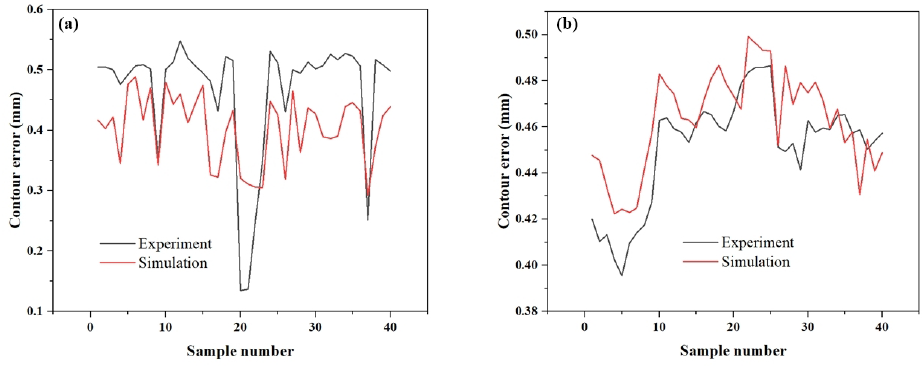
Figure 3. Prediction effect of contour error in (a) experiment 1 and (b) experiment 2.